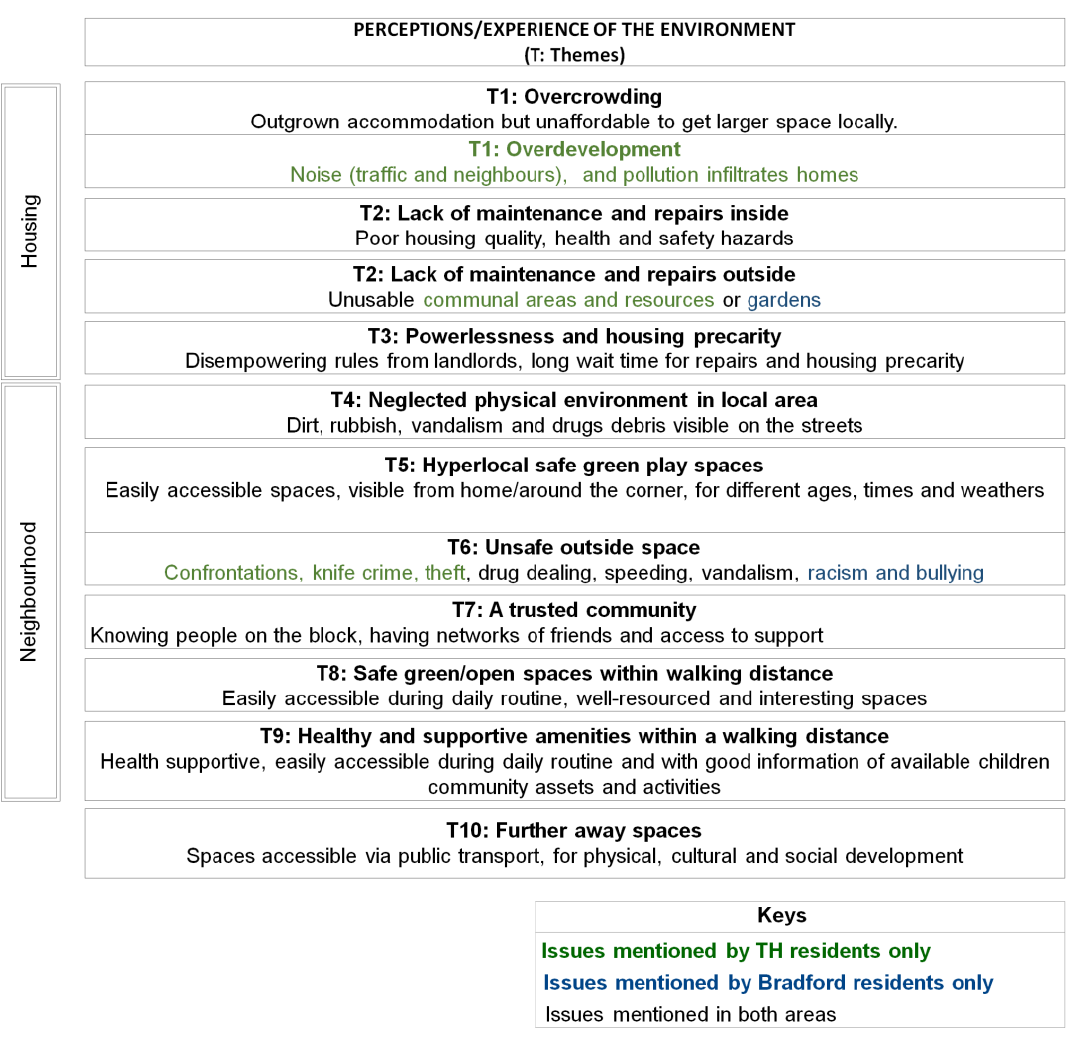
Figure 2. Themes — Perception and experiences of the environment. Figure 2. Themes—Perception and experiences of the